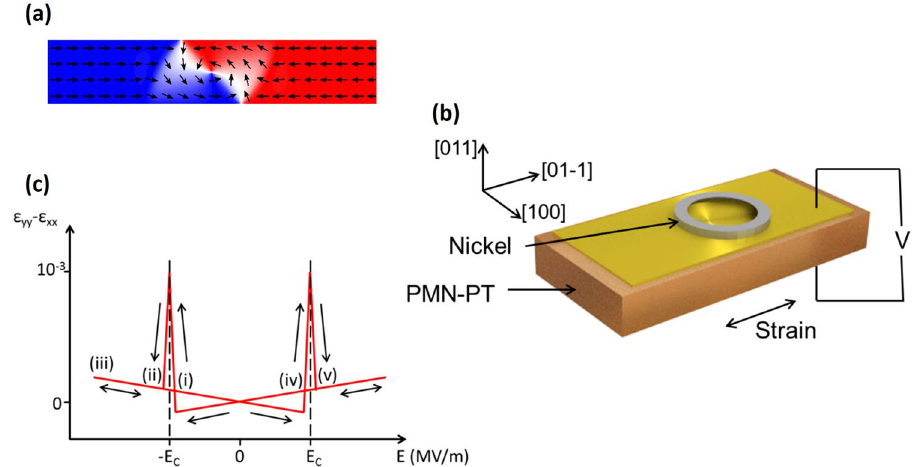
Figure 1. Device geometry and characteristics. ( a ) A representation of a vortex domain wall situated in a magnetic nanowire. Arrows represent the direction of the magnetisation. ( b ) A schematic of the device consisting of a nickel ring situated on top of a PMN-PT chip. A voltage applied across the thickness of the chip generates a uniaxial strain in the plane. ( c ) Schematic representation of the uniaxial strain as a function of the electric field applied to the PMN-PT, based on ref. 23. E C is the ferroelectric coercive field. Roman numerals correspond to the electric field values labelled in Fig. 2.